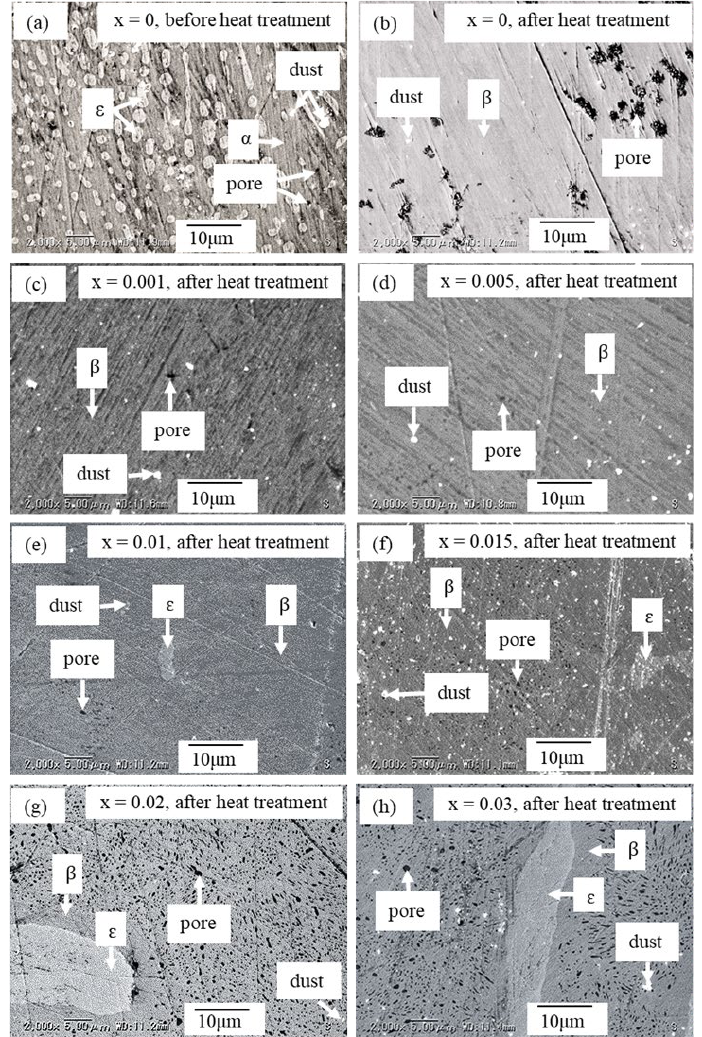
Figure 2. SEM image of β -Fe 1−x Ni x Si 2 : ( a ) before heat treatment for x = 0, ( b – h ) after heat treatment for 0 ≤ x ≤ 0.03.